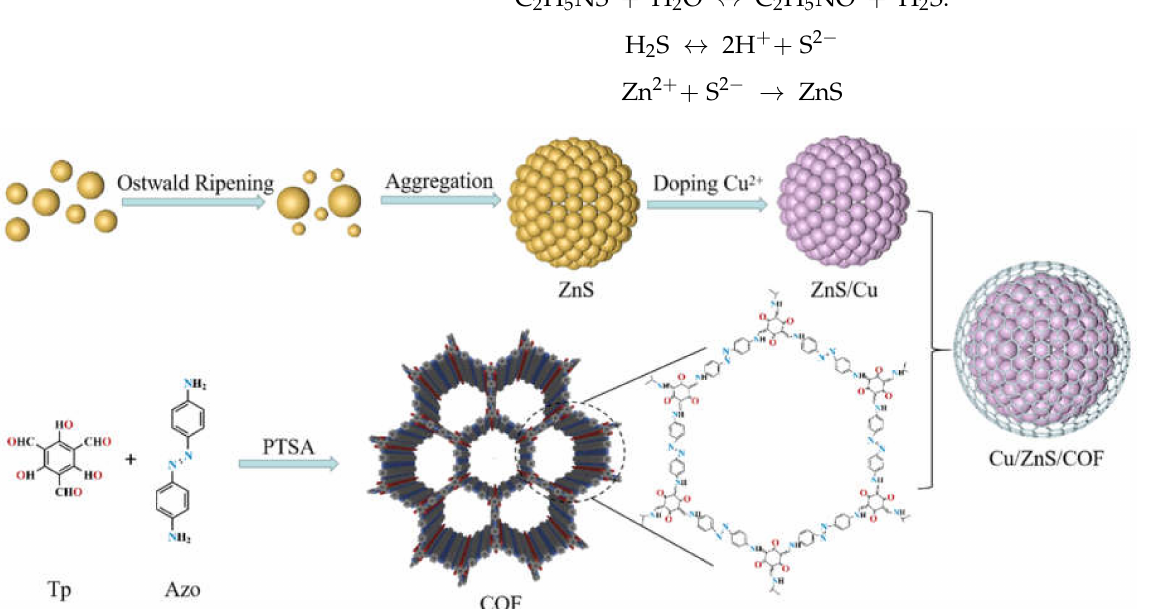
Figure 7. Schematic synthesis of Cu/ZnS/COF